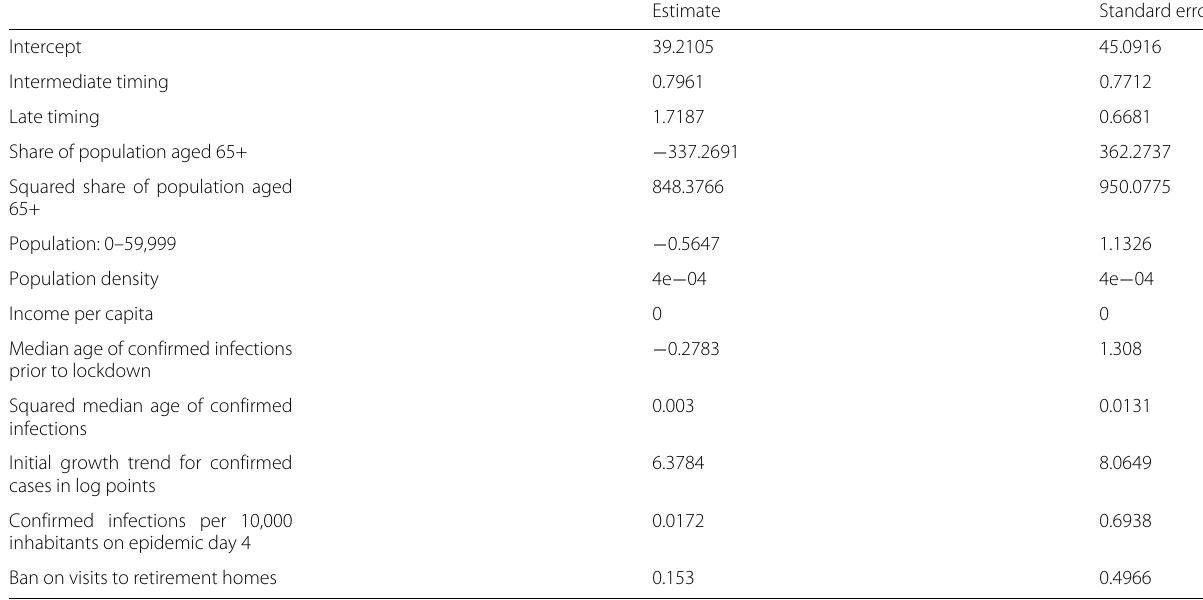
Table 5 OLS estimates for Switzerland and LI 44 days after the start of the canton-specific epidemic with fatalities per 10,000 inhabitants as outcome